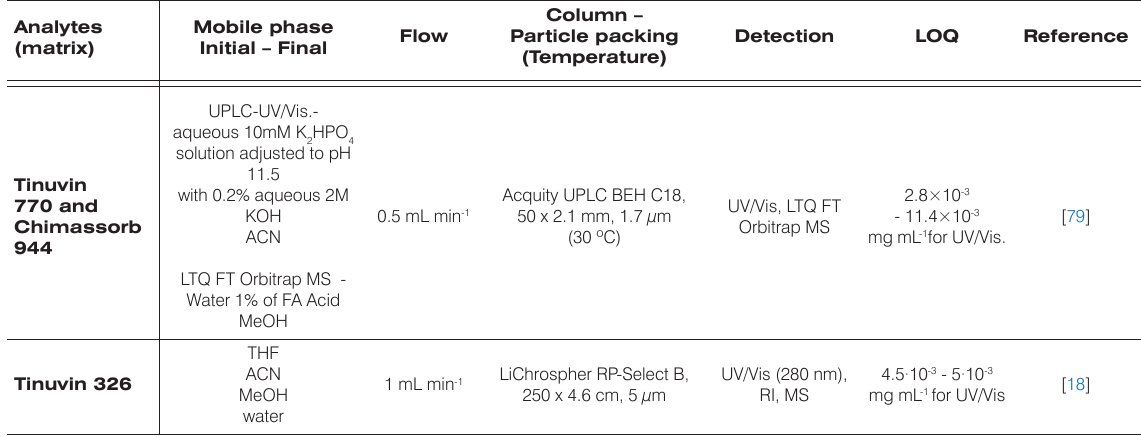
Table 4. Summary of liquid chromatography based methods for the determination of antistatics in plastics. Analytes